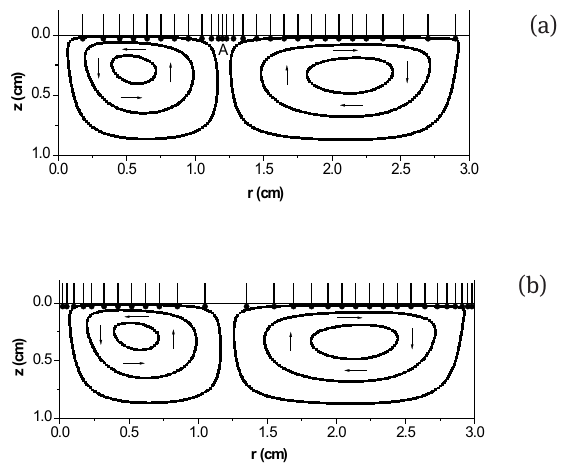
Figure 10: Schematics of the mechanism of spontaneous oscillation due to surfactant transfer in biphasic system: (a) the instability growth, (b) the instability termination (see the text for